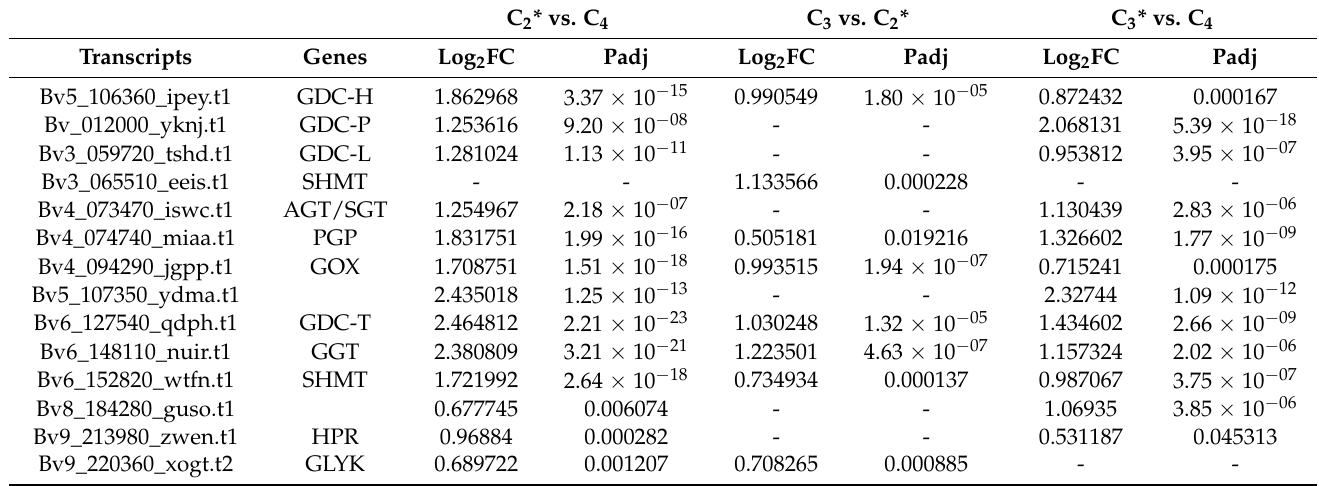
Table 2. Differential expression of photorespiratory transcripts in leaves between Camphorosmeae species. T. diffusa (C 3 ), Sed. sedoides (C 2 ), B. prostrata (C 4